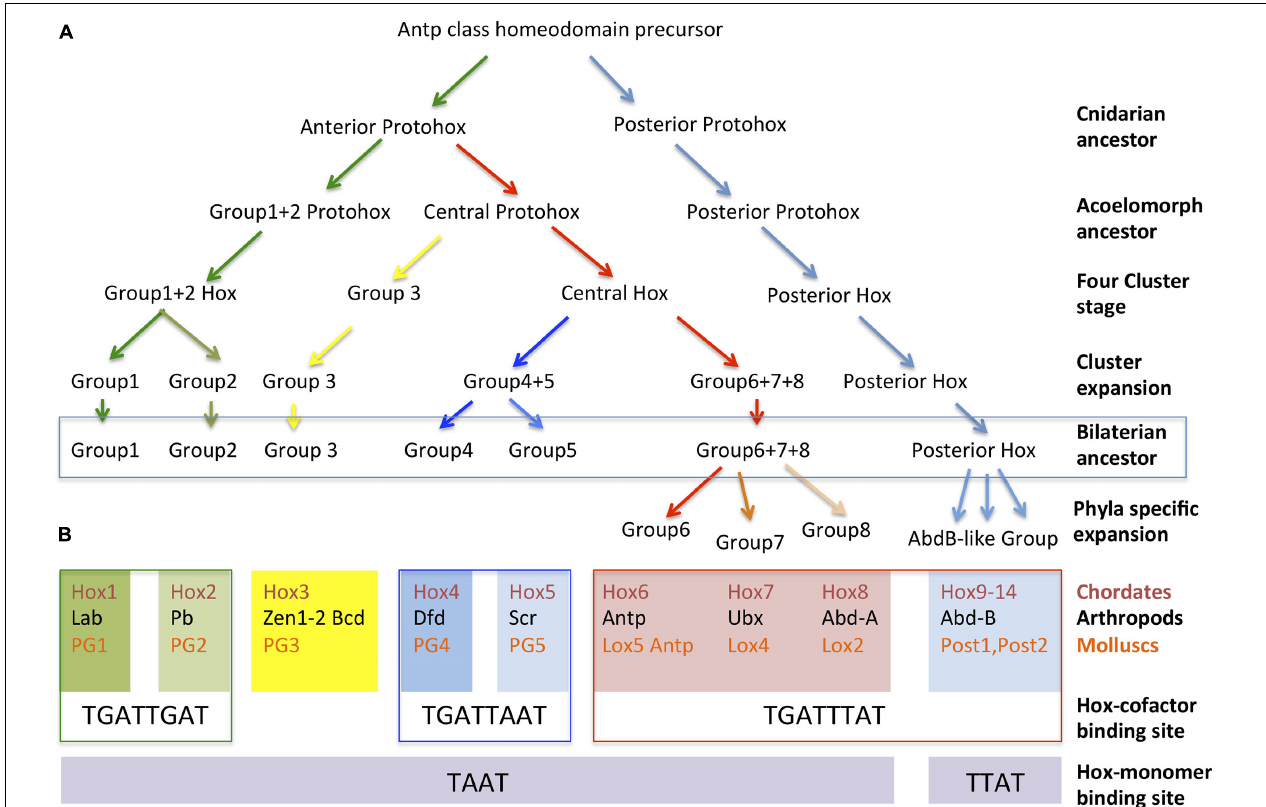
FIGURE 2 | Evolution of Hox protein clusters and correlation with their DNA binding preferences. (A) Inferred cluster evolution from sequential tandem duplications of an ancient Antp class homeobox gene. Three tandem duplications gave rise to a four-gene ProtoHox cluster. Duplication of the full ProtoHox cluster gave rise to the ParaHox cluster (not shown) and the Hox cluster proper. The duplication of specific genes in the four-gene Hox cluster resulted in its expansion in the common ancestor that gave rise to all bilateral animals. Phyla specific duplications resulted in the final expansion that resulted in the 10–15 Hox clusters found in modern species. (B) Classification of the Chordate, Arthropod, and Mollusc Hox proteins into paralogy groups according to their evolutionary relationships as inferred from their sequence similarities. Each of the seven groups is aligned over their preferred DNA binding sites either when in complex with TALE cofactors or as monomers. For simplicity, the Hox6-Hox8 genes have been organized in columns aligned with particular arthropod and mollusc equivalents, even though direct homology for genes in the column has not been demonstrated, see